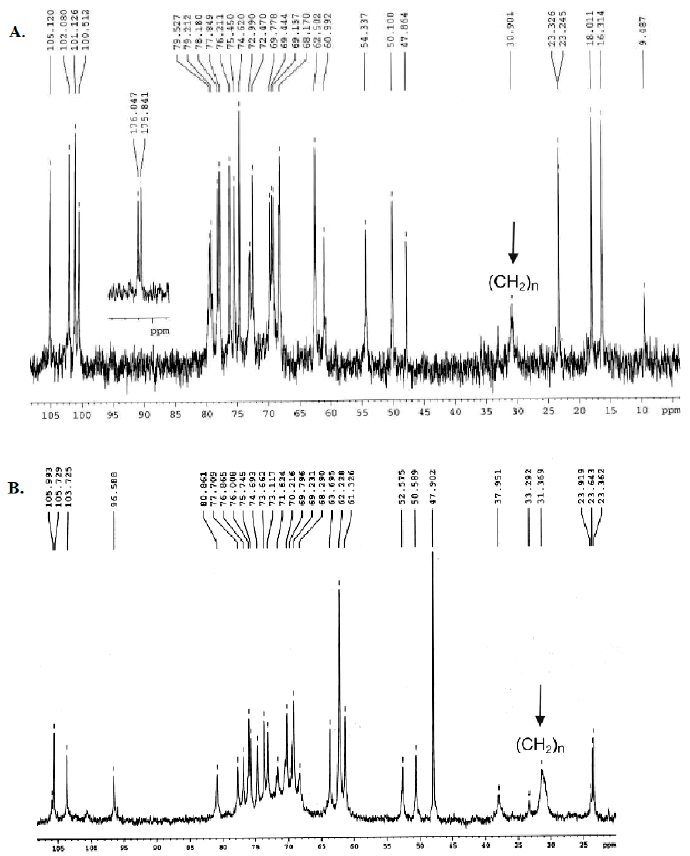
Figure 3. 13 C NMR spectra of Ac 3 -S-LPS E. coli O157 ( A ) and Ac 3 -S-LPS E. coli O104 ( B ). (CH 2 ) n indicates methylene groups of fatty acids.